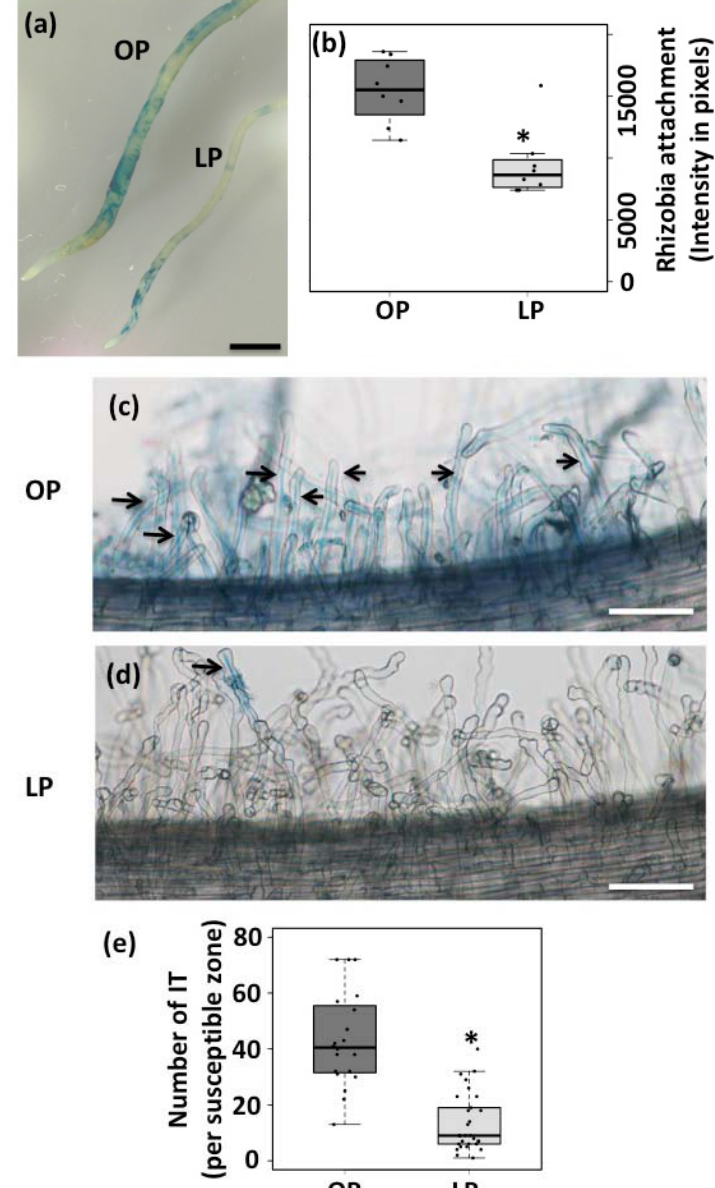
(horizontal box side), minimum and maximum (outside whiskers). Asterisk indicates a significant difference according to one-way analysis of variance (ANOVA) ( p -value < 0.001). Data showed was obtained from 20 biological replicates, each one containing 10 roots from different common bean seedlings. ( e ) Types of aberrant rhizobia-induced root hair deformation observed in common bean seedlings growing under LP conditions. Scale bars in panel represent 50 μ m.